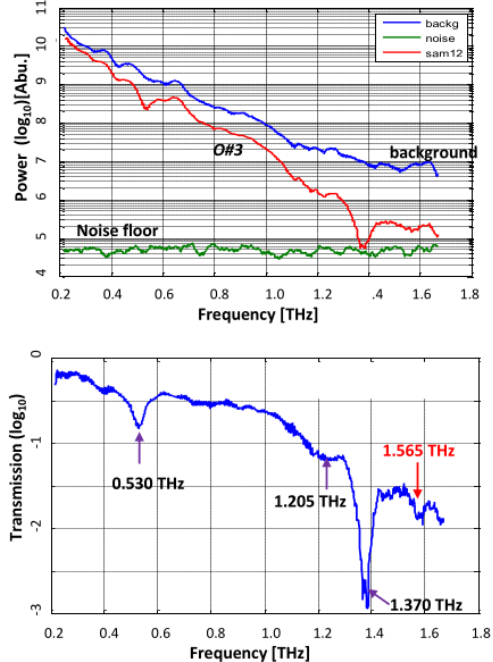
Figure 8. Spectra of oxycodone O#3. ( Top ) Power (arbitray unit) vs. frequency (THz); ( Bottom ) transmission vs. frequency, which is corrected with an offset